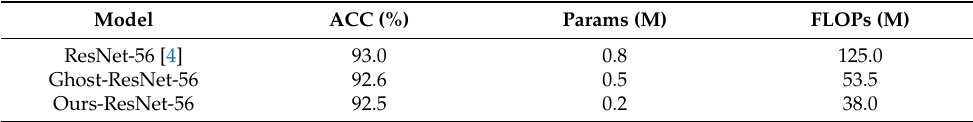
Table 4. Performance of the compared methods on